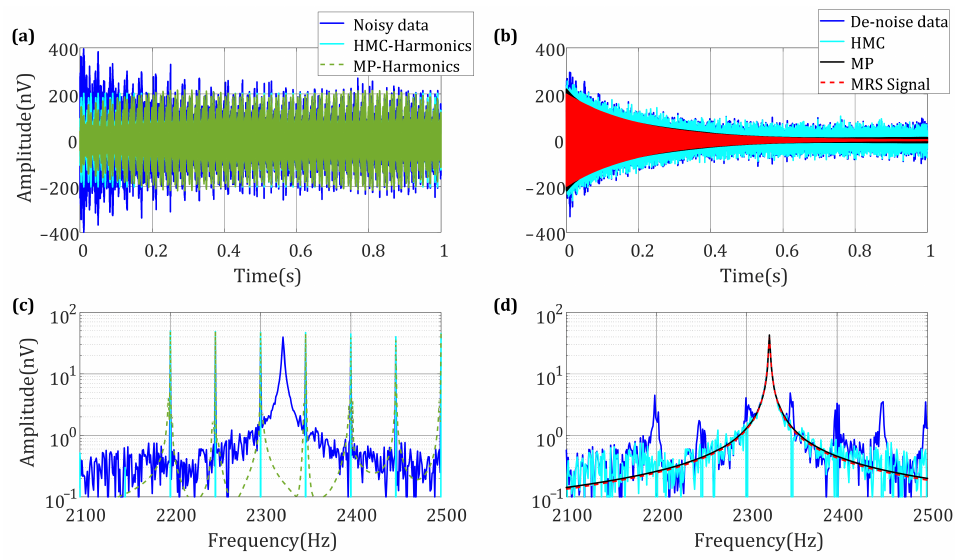
Figure 1. Denoising results of the MP algorithm when SNR = − 5.98 dB: ( a ) noisy data and reconstructed power-line harmonics by MP and HMC; ( c ) is the corresponding spectrum. ( b ) After removing the harmonics, the MRS signal is extracted by MP and HMC; ( d ) is the corresponding